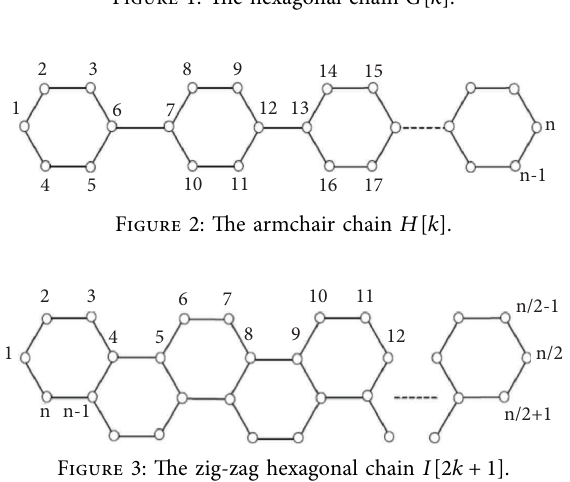
Figure 1: Te hexagonal chain G [ k ] .